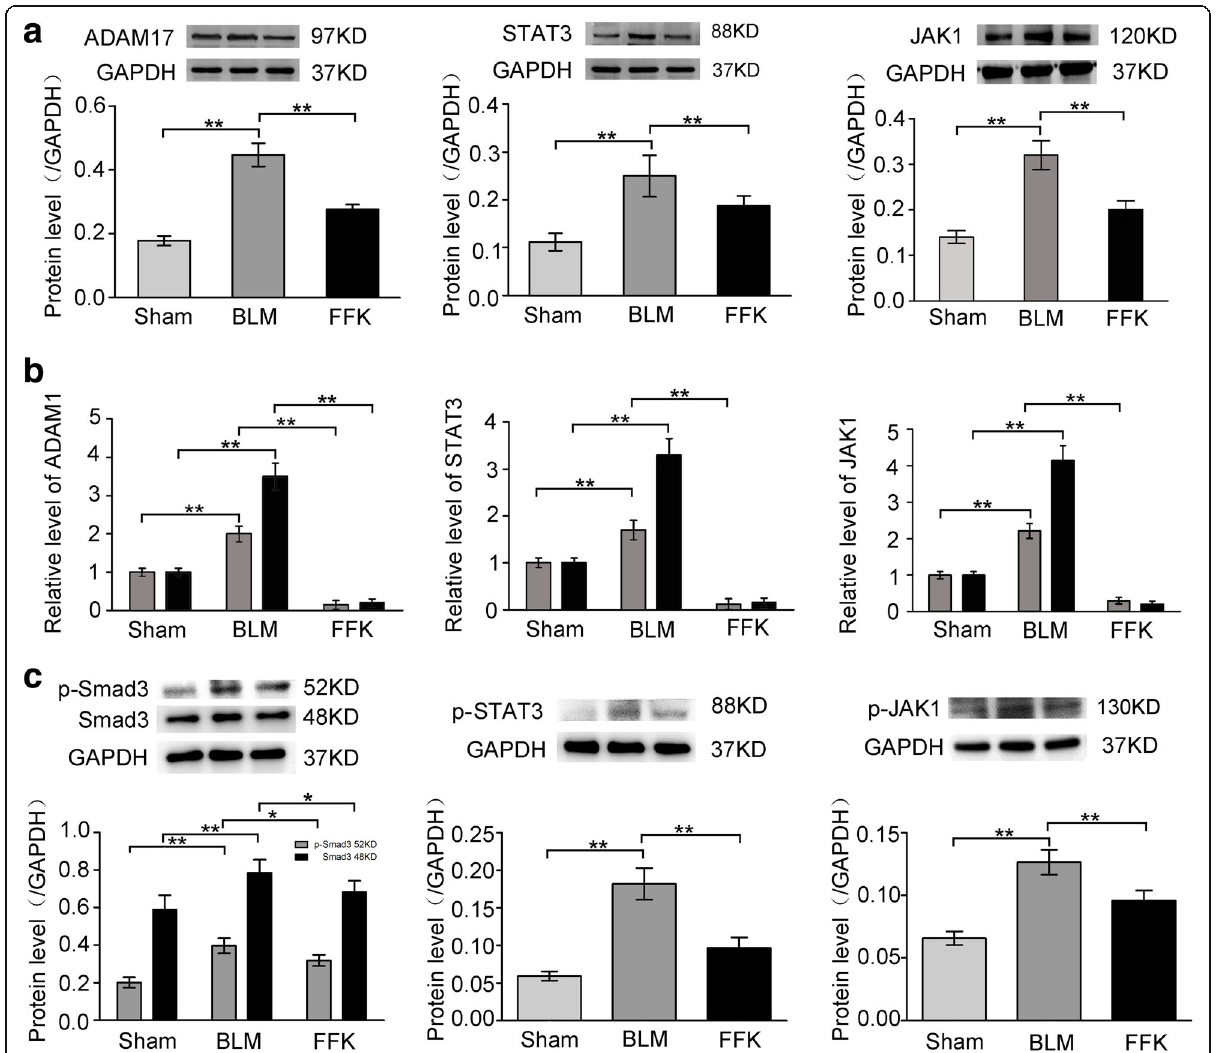
Fig. 7 Expression of JAK1, STAT3 and ADAM17 were tested in mice. a Protein expression level of JAK1, STAT3 and ADAM17 by using Western blot. FFK remarkably decreased JAK1, STAT3 and ADAM17 protein expressions compared with BLM. b mRNA expression level of JAK1, STAT3 and ADAM17 by using qRT-PCR and RNA-sequencing. FFK remarkably decreased JAK1, STAT3 and ADAM17 mRNA expressions compared with BLM. c Western blot showed that FFK reduced p-SMAD3, p-STAT3 and p-JAK1. Data are shown as means ± SD, n = 6, ** P <